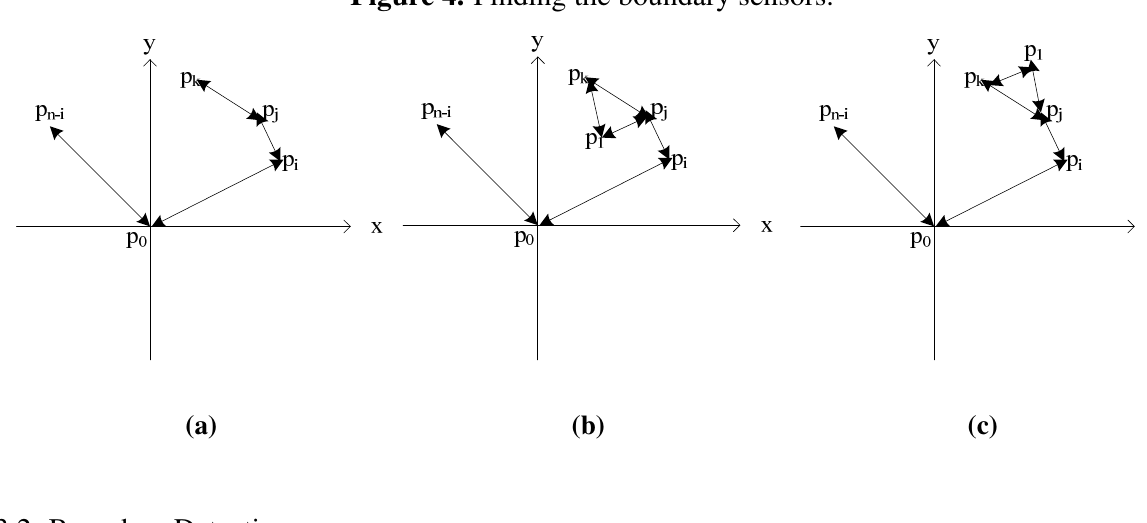
Fig.4 finding the boundary sensors Table 3. Finding the boundary sensors (FBS) algorithm Algorithm: Finding the boundary sensors